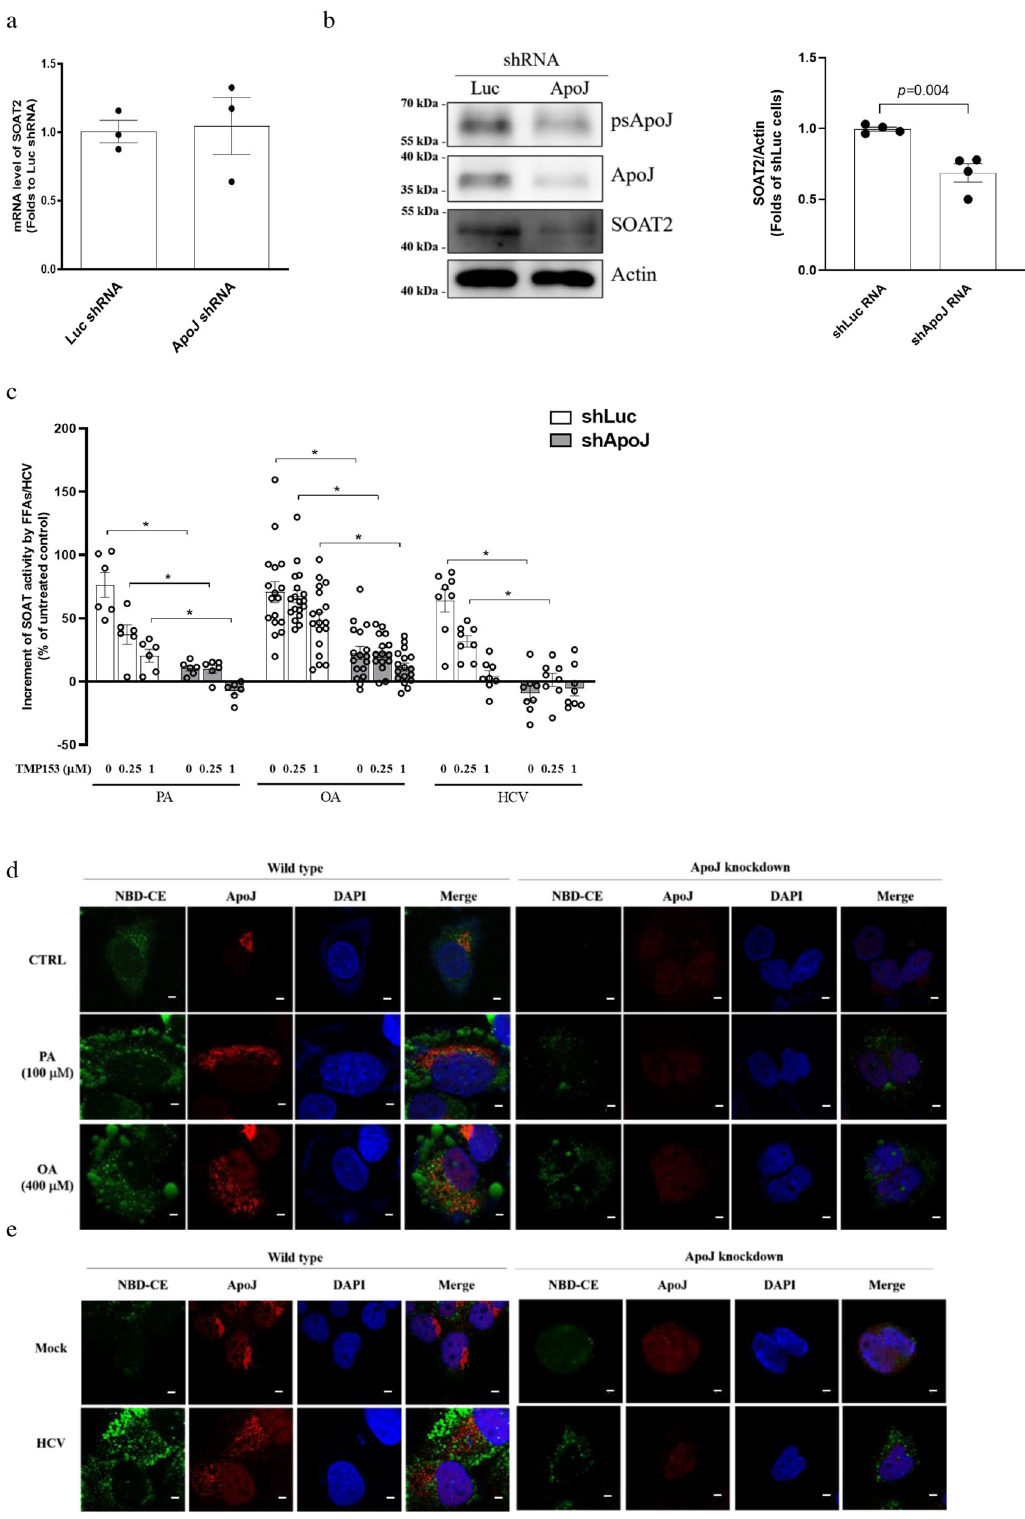
Fig. 4 ApoJ silencing reduced SOAT2 expression and SOAT enzymatic activity. Huh7.5 cells bearing Luc or ApoJ shRNA were established to examine a SOAT2 mRNA ( n = 3); b SOAT2 protein expression (representative image in left panel; SOAT2 intensity in right panel, n = 4) and; c SOAT enzymatic activity in the presence of FFAs or HCV infection at MOI = 0.01 for 6 days with and without TMP153 treatment; and d , e image visualization of NBD-CE under confocal microscopy observation. The data were presented as the mean ± SEM ( n ≧ 6), and asterisks indicate statistical signi fi cance ( p < 0.05) between the control and ApoJ knockdown cells. Scale bar, 5 μ